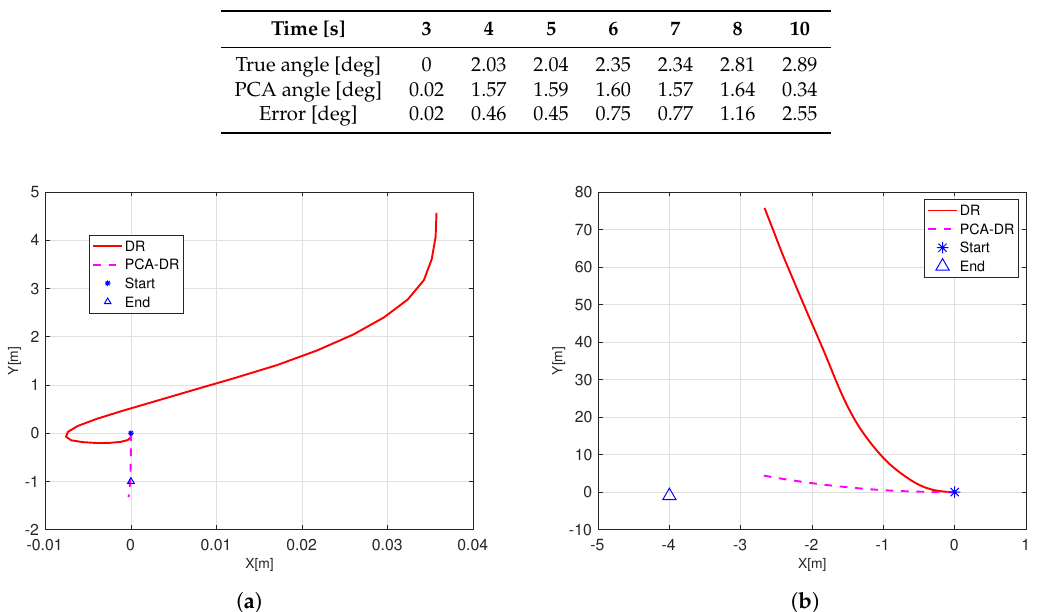
Figure 12. Results from the sea experiment comparing PCA-DR with the traditional DR approach. ( a ) Trajectory A. Data collected for 3 s. ( b ) Trajectory B. Data collected for 10